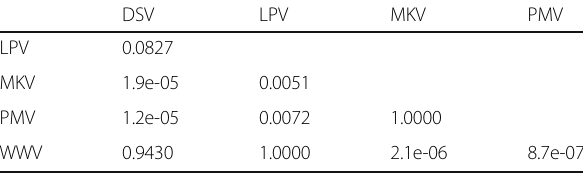
Table 1 Pairwise comparisons using Wilcoxon rank sum test DSV LPV